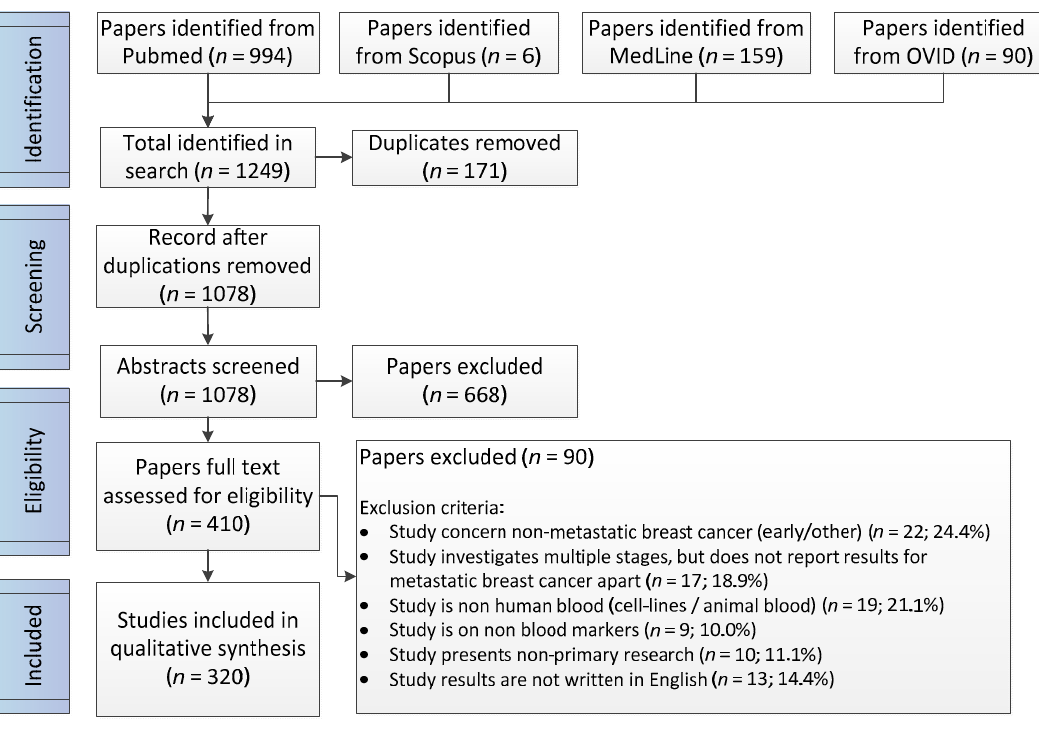
Figure 1. PRISMA Flow Diagram.